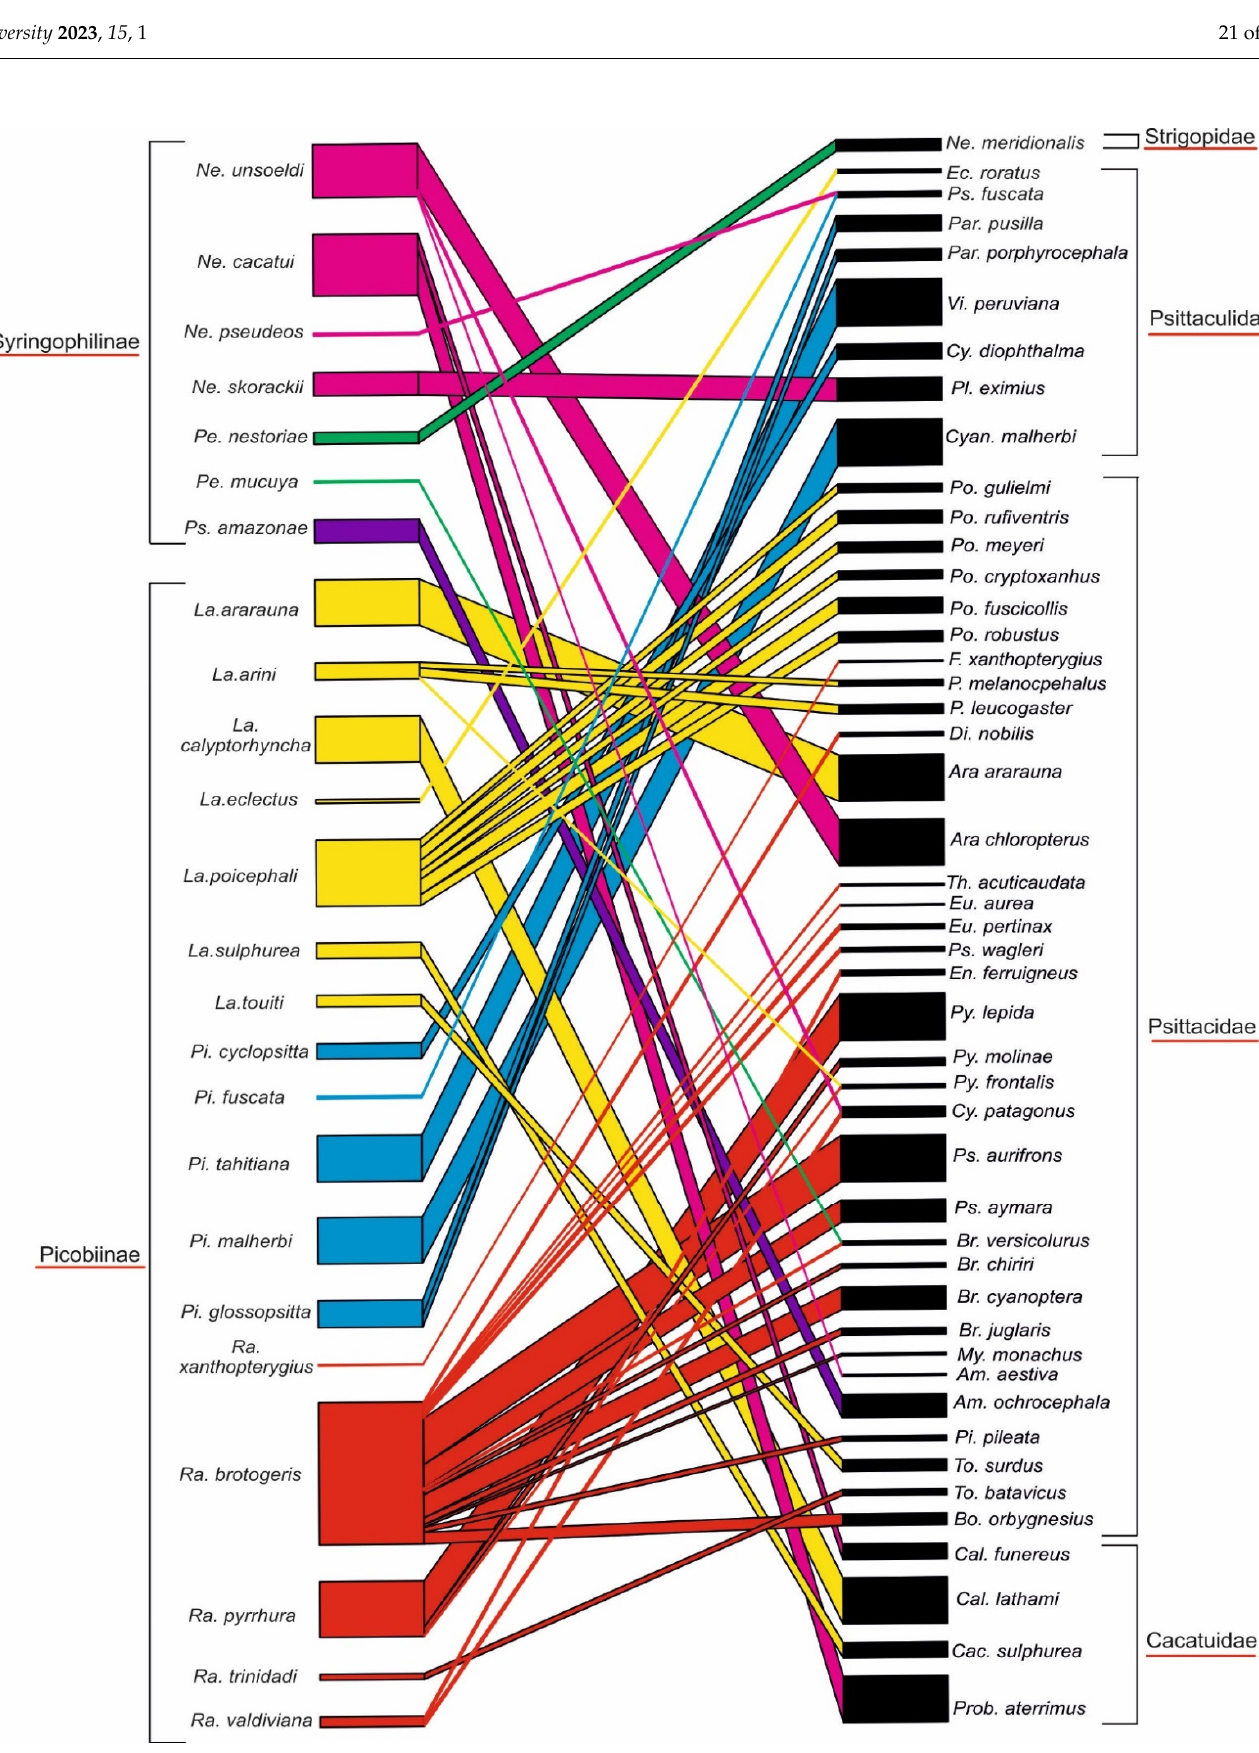
Figure 1. Bipartite network graph of interactions between quill mite species (left) and their parrot hosts (right).